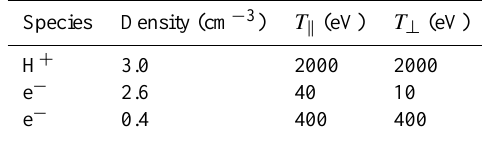
Table 1. The plasma model. All components are assumed to be Maxwellians. The model is based on PEACE and CIS